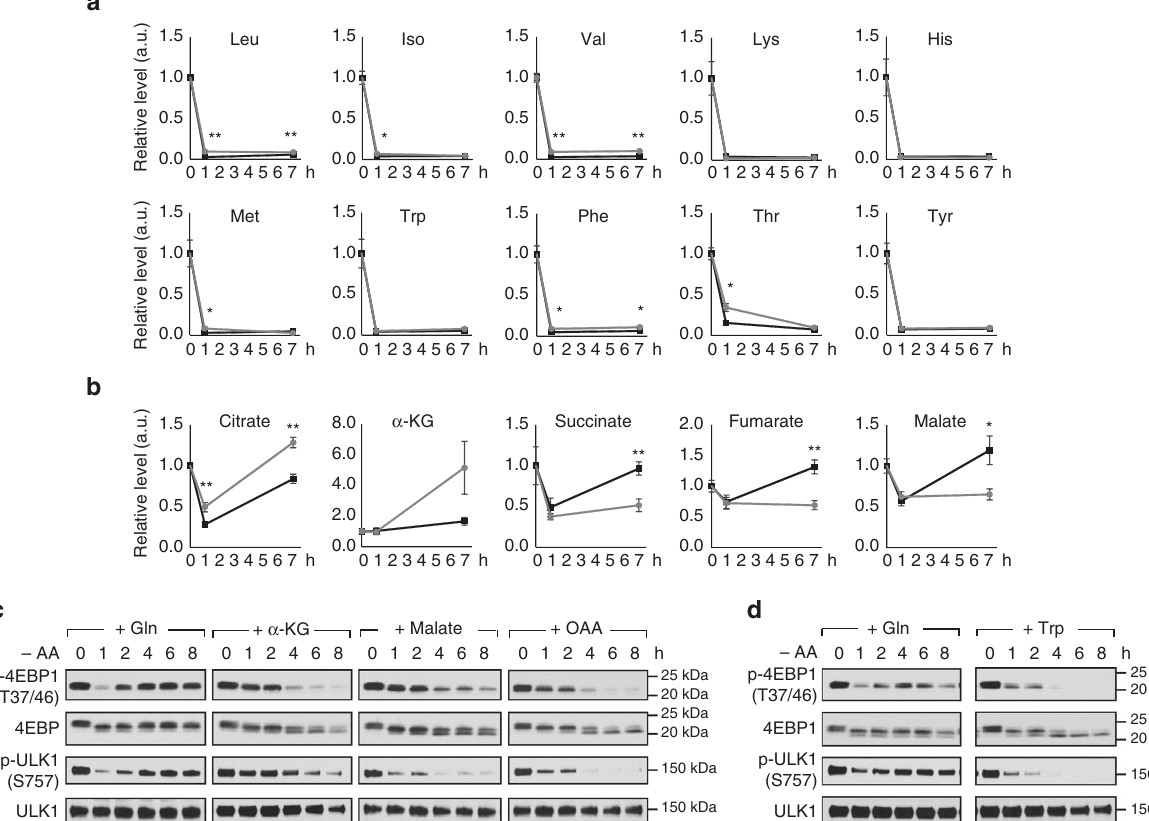
Fig. 4 Glutamine reactivates mTORC1 signaling independent of EAAs. a , b Wild-type MEFs were starved of amino acids with ( black line ) or without ( gray line ) the supplementation of glutamine (4 mM) for the indicated durations. Individual essential amino acid a and TCA cycle intermediate b levels were measured from cell lysates by GC-TOF-MS. Data are expressed as the fold change of control cells (unstarved control, 0 h). Data are the mean ± SEM of n = 4 – 5, * P ≤ 0.05; ** P ≤ 0.01 (between the groups with and without glutamine supplementation at the same time point via Student ’ s t -test). c Wild-type MEFs were subjected to amino acid starvation with the supplementation of 4 mM glutamine, dimethyl- α -KG, malate or OAA for the indicated durations. d Wild-type MEFs were starved of amino acids with the supplementation of glutamine (4 mM) or tryptophan (4 mM) for the indicated durations. Changes in mTORC1 activity were assessed by immunoblotting of p-4EBP1 and